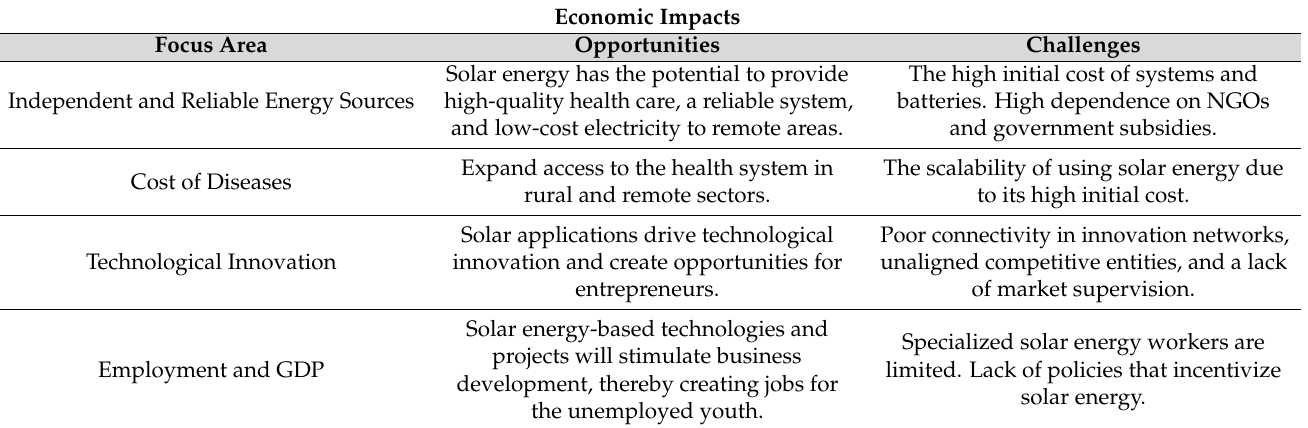
Table 3. Summary of opportunities and challenges for the use of solar energy in health facilities— economic